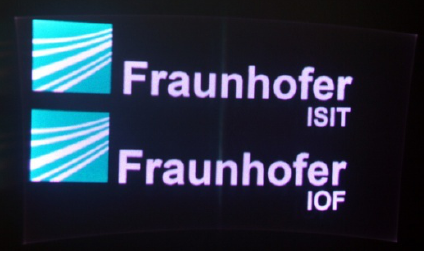
Figure 25. Suppressed reflex by use of a vacuum packaged mirror with tilted